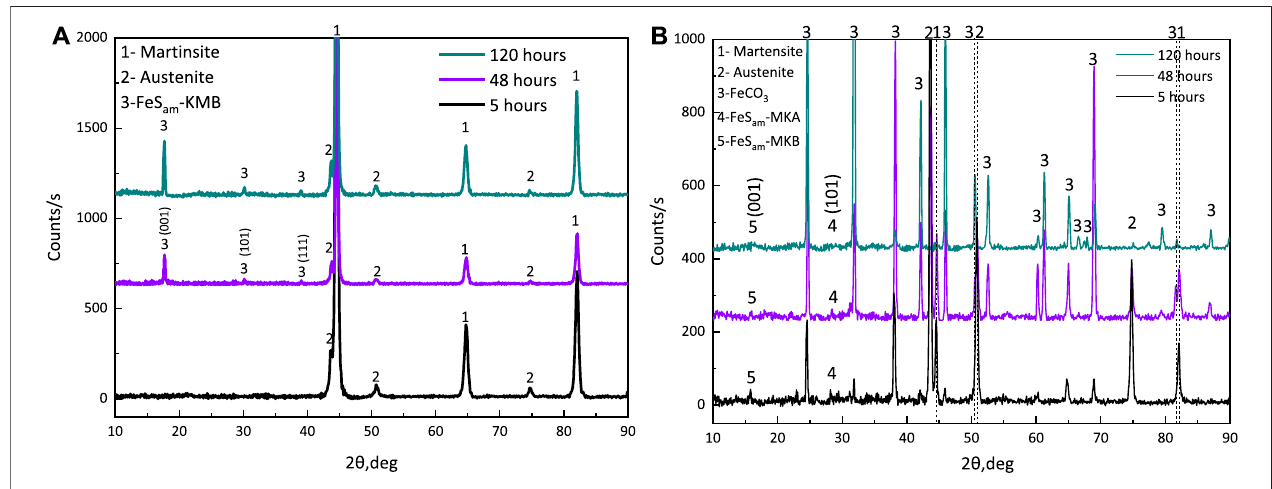
FIGURE 4 | XRD patterns of the corrosion scale formed on S13Cr SS under the 180 ° C formate condition with (A) N 2 or (B) CO 2 saturated after 5, 48, and 120 h.